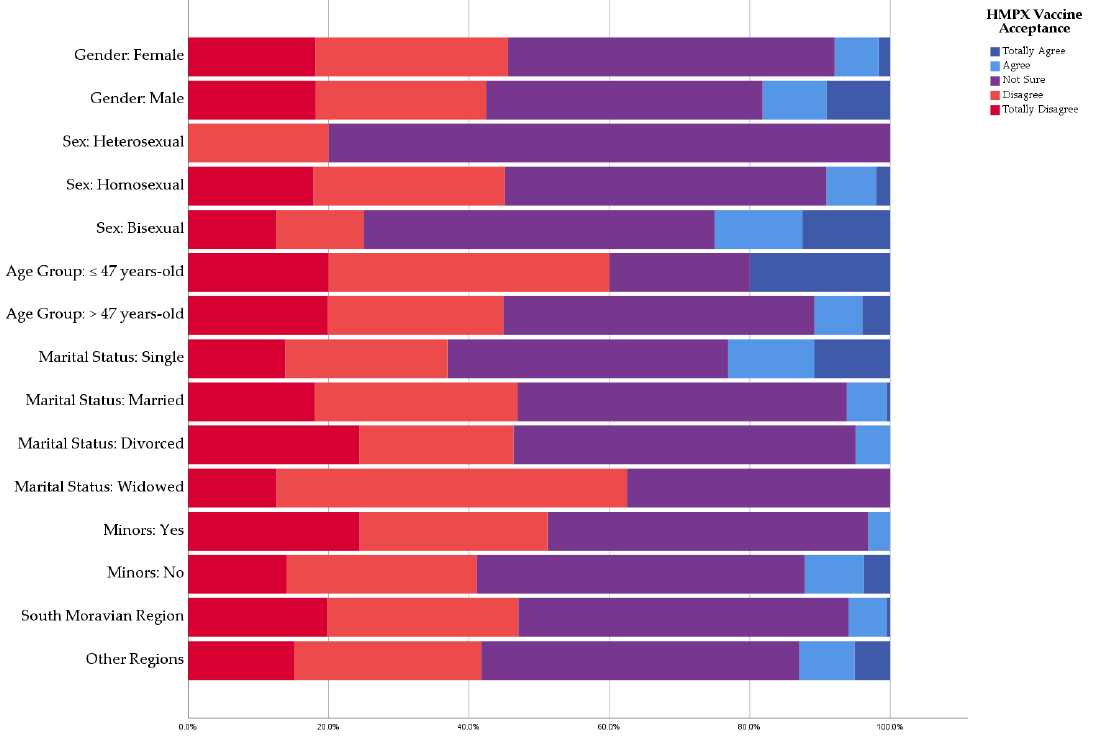
Table 8. HMPXV vaccine recommendations and willingness to Pay (WTP) of Czech HCWs responding to the HMPXV survey, September 2022 ( n =